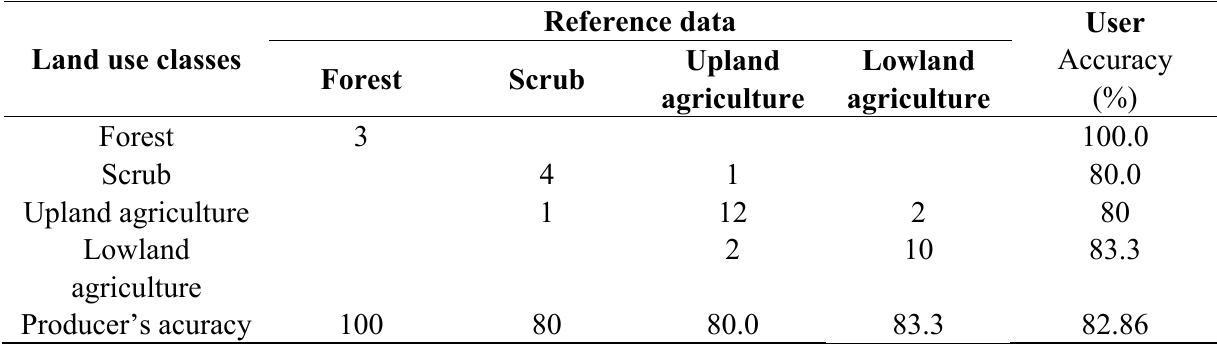
Table 3. Error Matrix of the Supervised Classification map of Galaudu Watershed, Nepal.